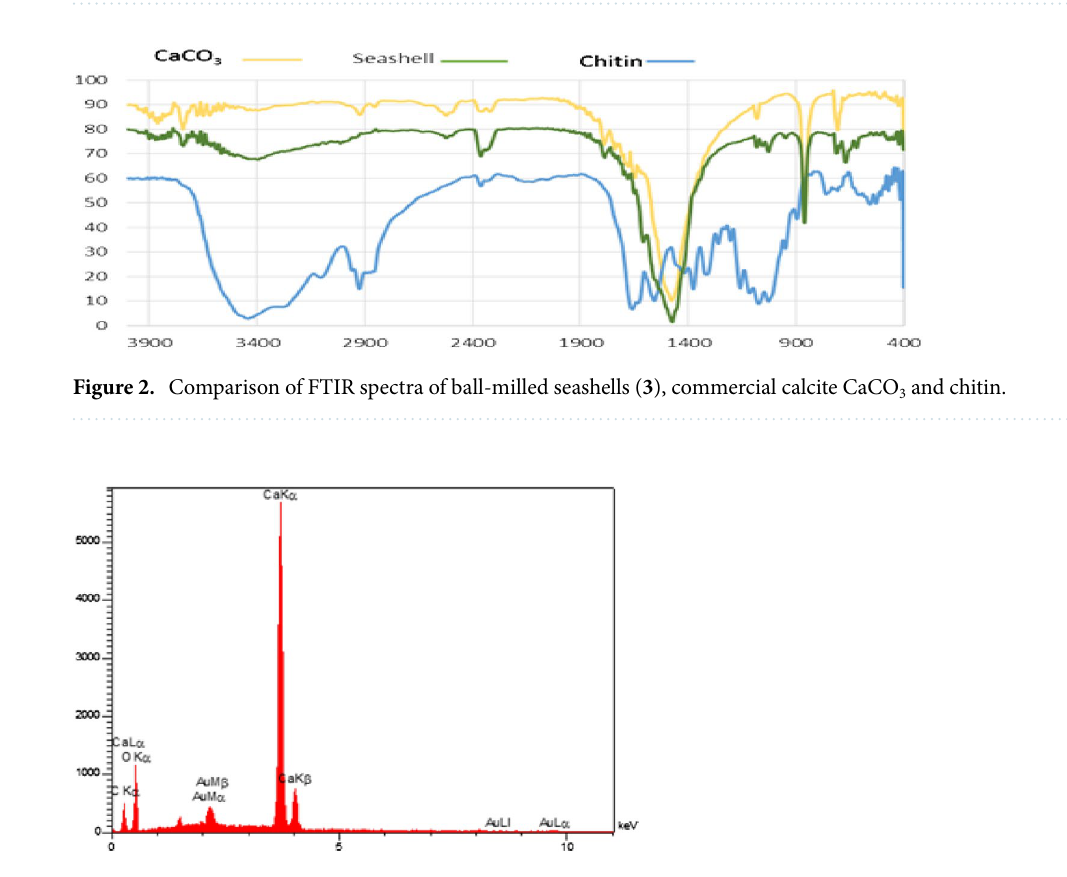
Figure 1. Synthesis of isoamyl acetate ( 4 ) catalyzed by the ball-milled seashells nanocomposite ( 3 ) under solvent-free conditions.